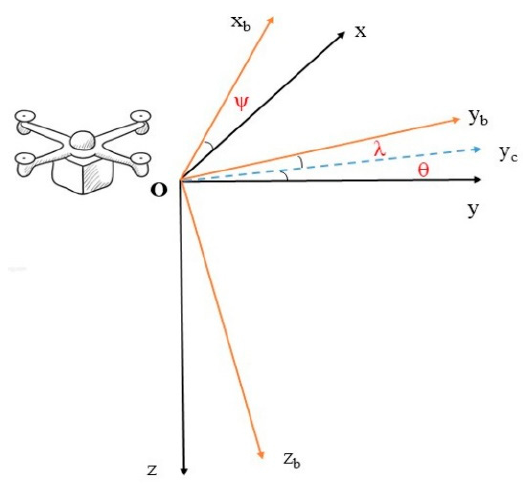
Figure 1. Coordinate system conversion